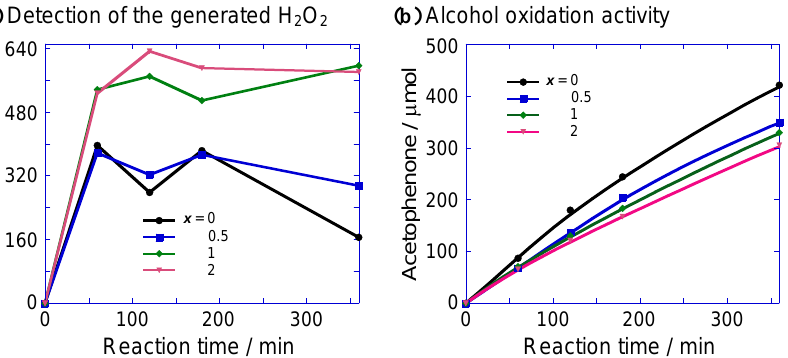
Figure 9. Effects of titanium sites on Au/Ti( x )-SBA SH (0.5): ( a ) Detection of H 2 O 2 generated during the oxidation of 1-phenylethanol, ( b ) time course of 1-phenylethanol oxidation with O 2 .